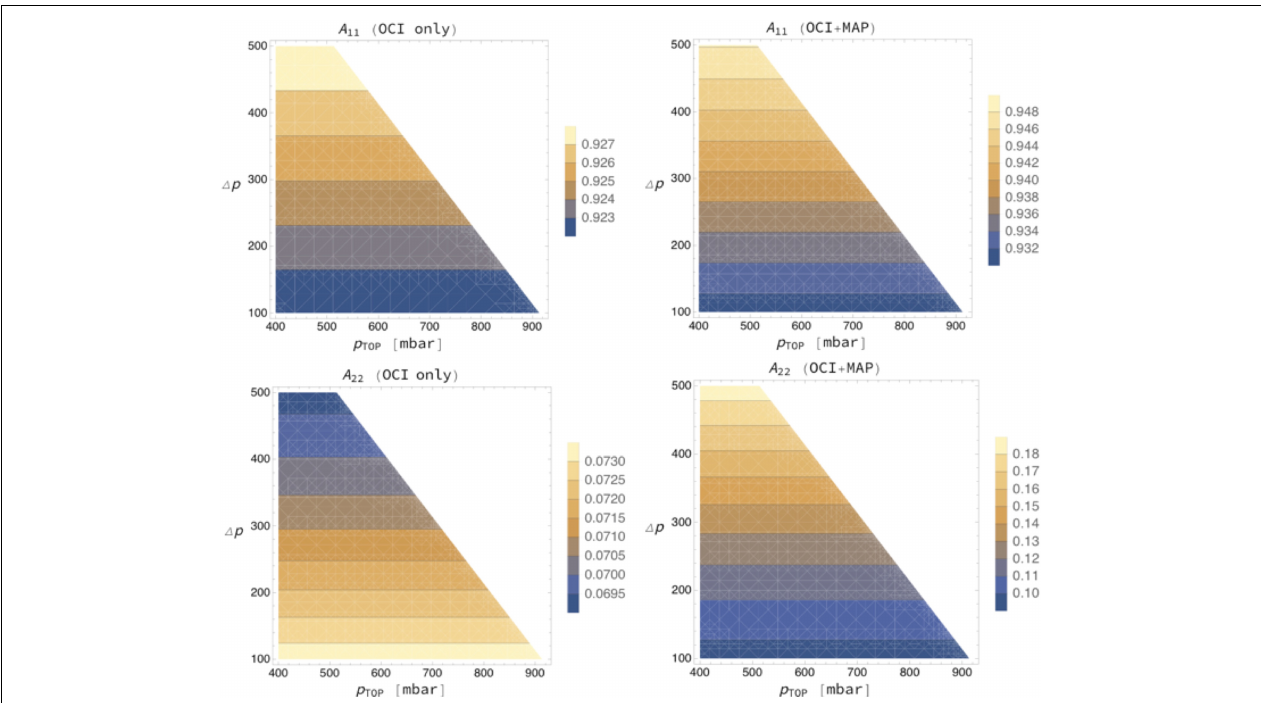
FIGURE 5 | (Upper left) Degree of freedom A pt (denoted A/d11/n) associated with aerosol layer top pressure p top (which has index i = 1 in the state vector/bx/n) as retrieved by OCI only with a posterior uncertainty of σ pt based on a prior uncertainty of σ a , pt = 250 hPa; DOAS ratio measurement uncertainty is assumed to be 1.5% and aerosol optical depth is taken to be 0.1 at O2A wavelengths, with ± 0.025 error. (Lower left) Same as upper-left, but for A (cid:49) p (denoted A/d22/n) associated with aerosol layer pressure thickness (cid:49) p (which has index i = 2 in the state vector/bx/n), using σ a ,(cid:49) p = 150 hPa. (Upper right) As for (upper left) but with additional information from collocated multi-angle observations. (Lower right) As for (upper right) , but for (cid:49) p rather than p top . Details explained in Davis and Kalashnikova (2019).